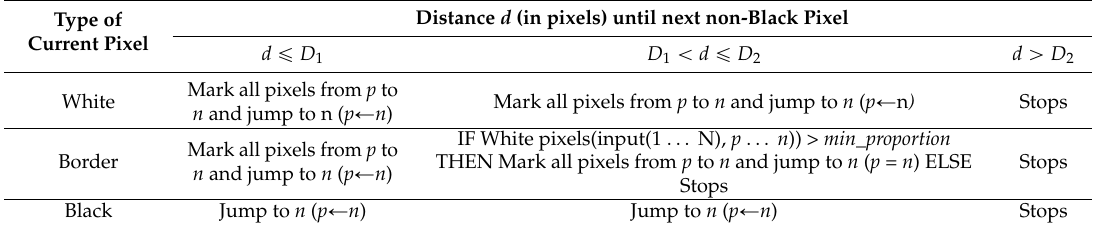
Table 1. Crop row detection method.